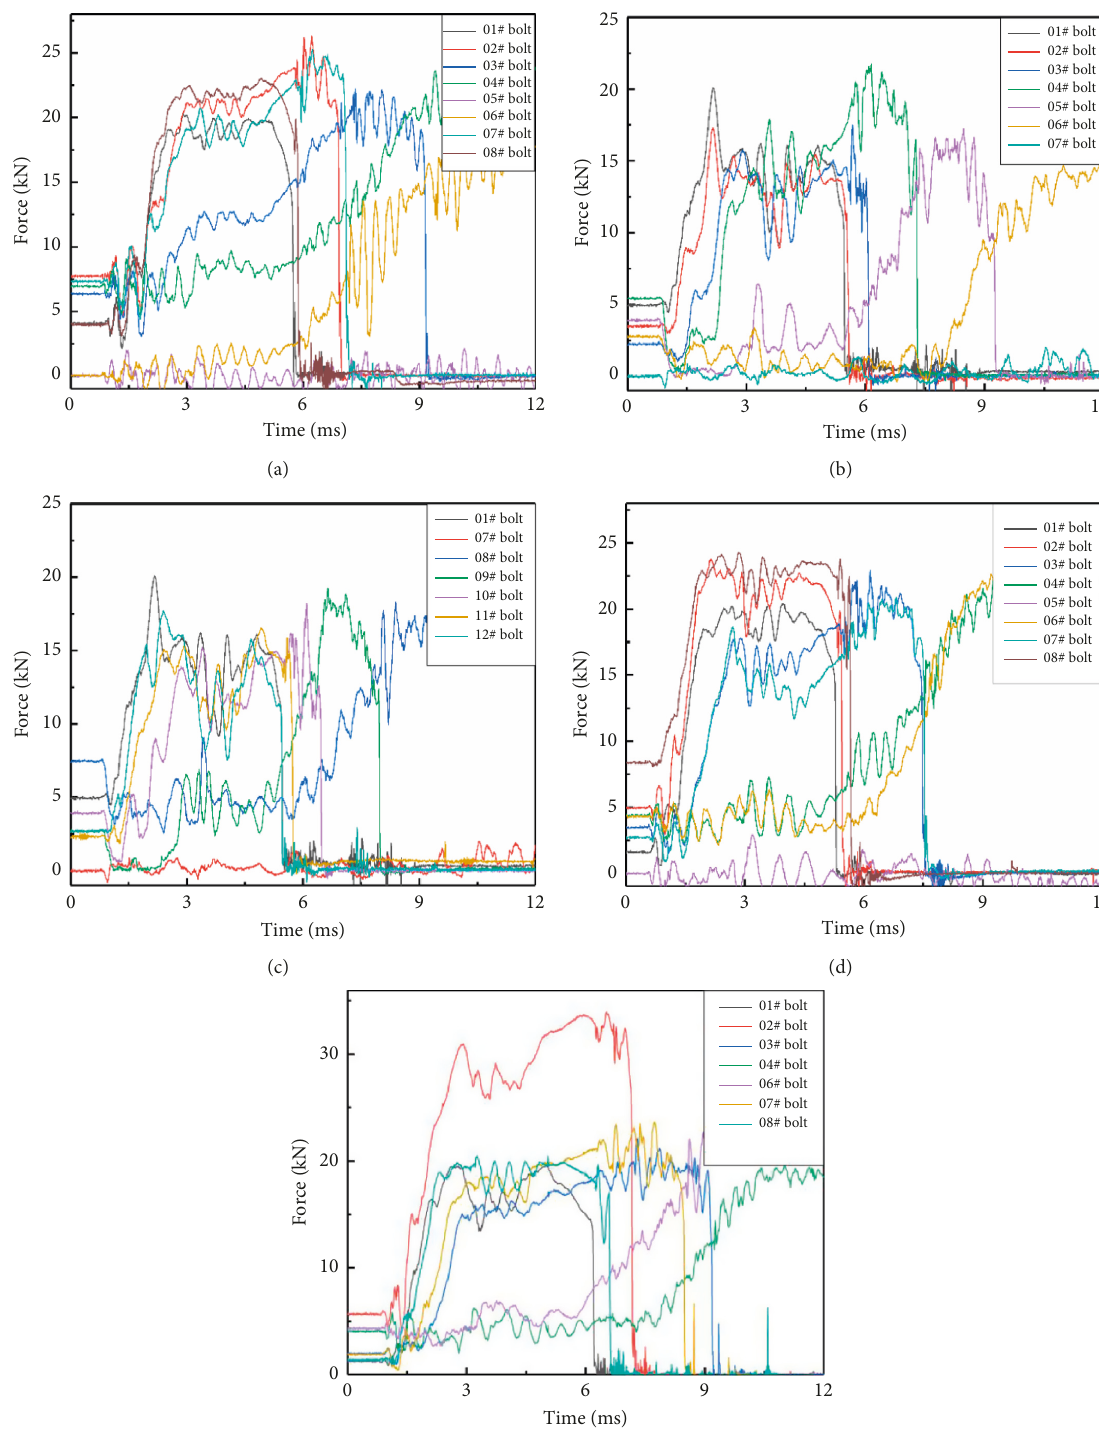
Figure 14: The response curves of the bolts force (experiment). (a) T-1, (b) T-2(1), (c) T-2(2), (d) T-3, and (e)